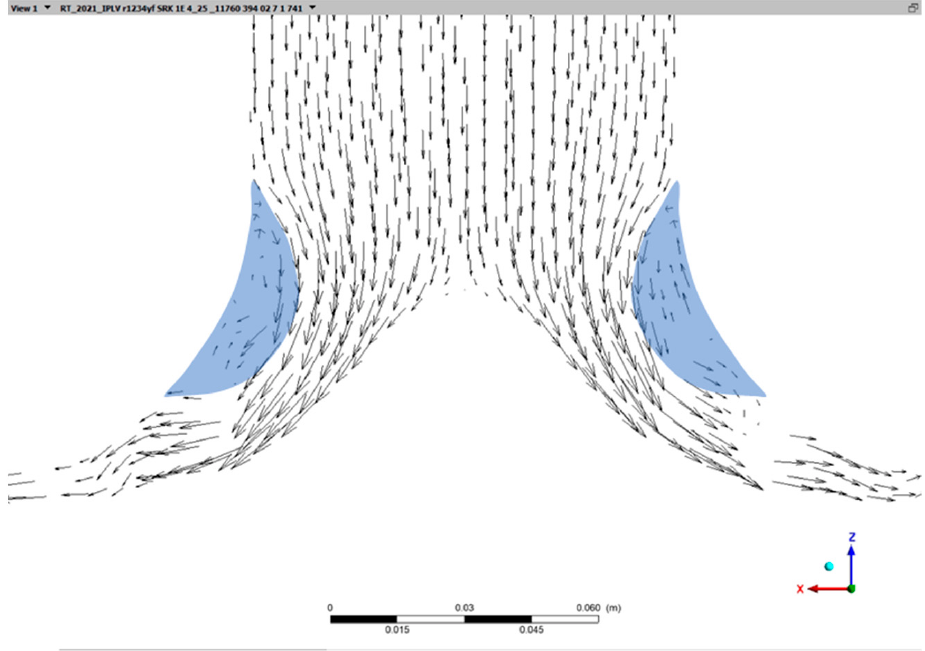
Figure 22. Compressor impeller velocity vector diagram of R-134a refrigerants under 25% load.